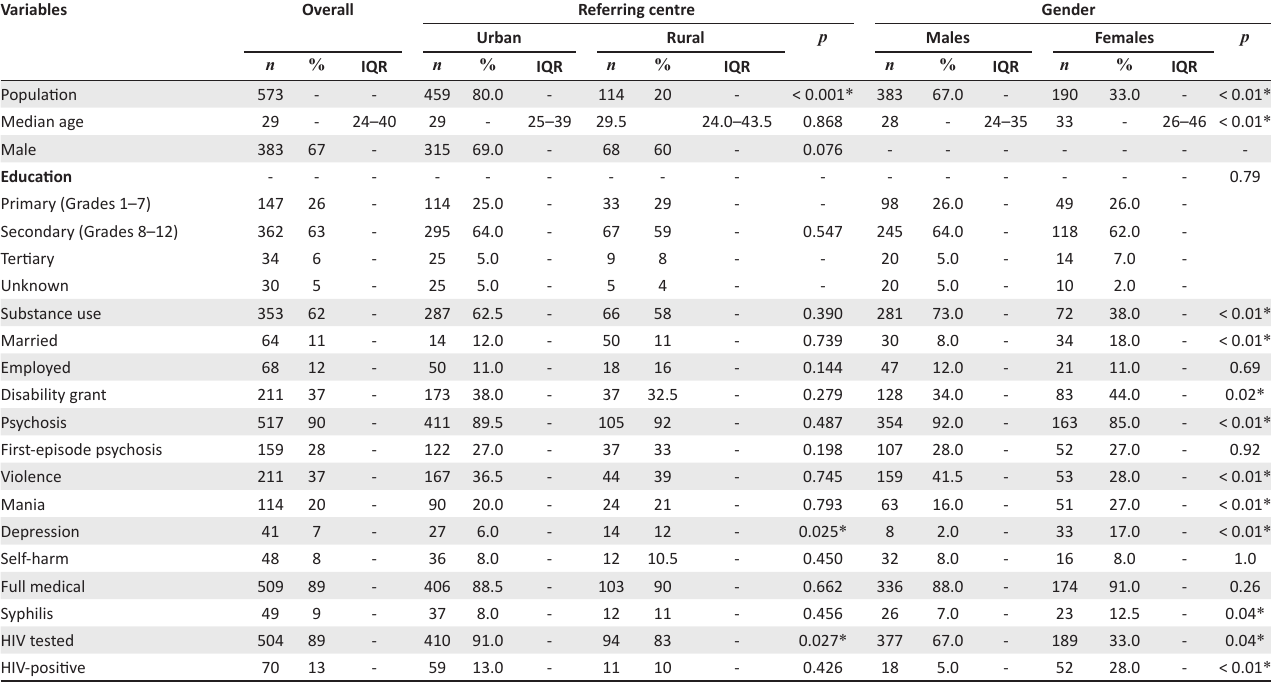
TABLE 1: Patient demographics and clinical characteristics with bivariate analysis across urban and rural drainage zones and in terms of gender. Variables